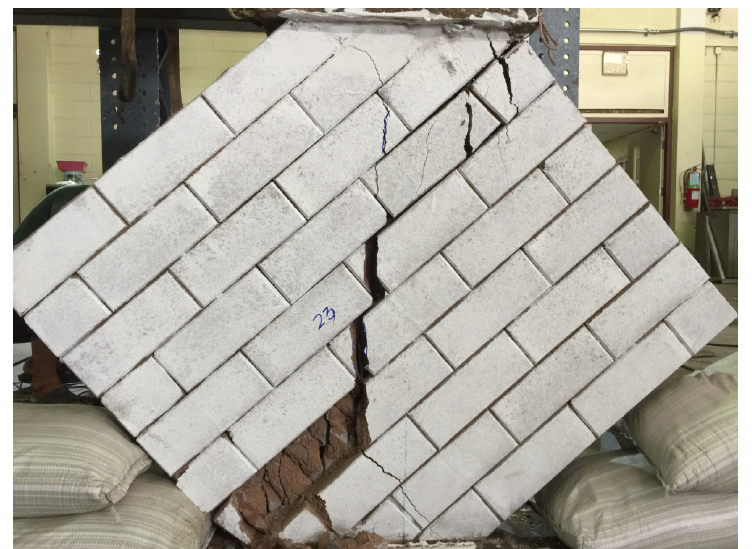
Figure 19. Ultimate failure mode of wall (W-CON).